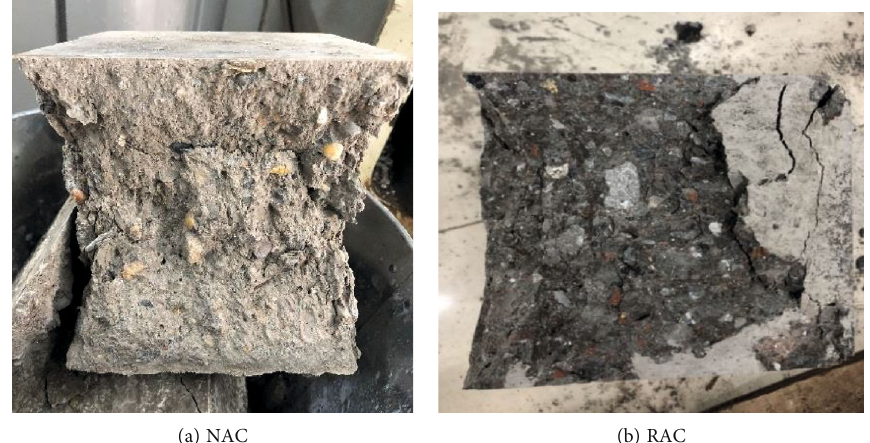
Figure 7: Compression failure morphology at the interfacial transition zones.